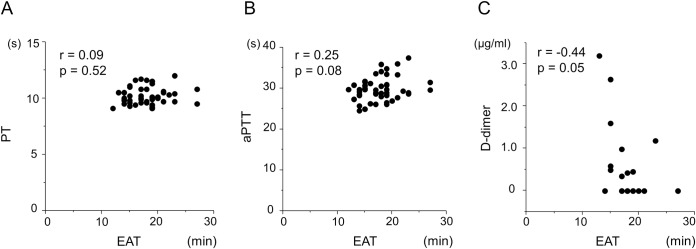
Correlation between the EAT and PT, aPTT, and D-dimer.Scatter-plots are shown between the EAT and PT (A), aPTT (B), and D-dimer (C). All of them exhibited no statistically significant correlations.